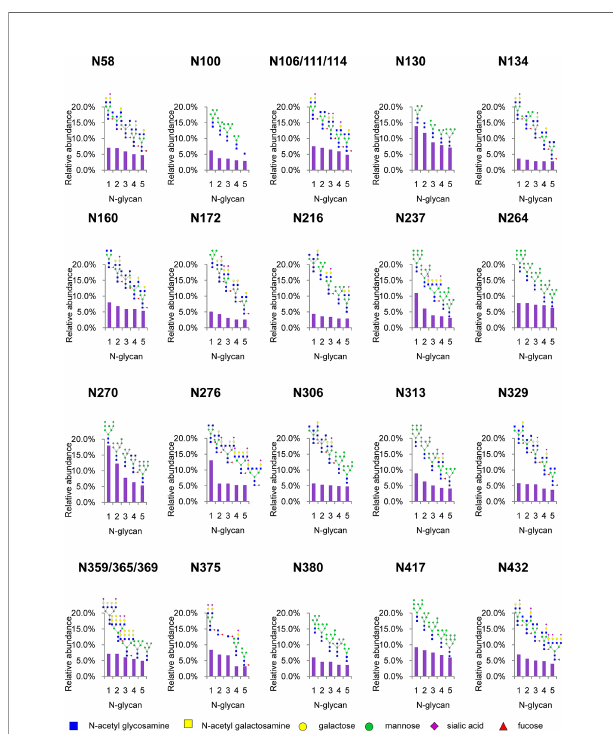
FIGURE 5 | Relative abundance of the top fi ve N-glycans on individual glycosites of recombinant HIV-1 gp120 protein. The data represent the relative ratio of each N-glycans on one glycosite. Three replicates were used for the fi nal statistical